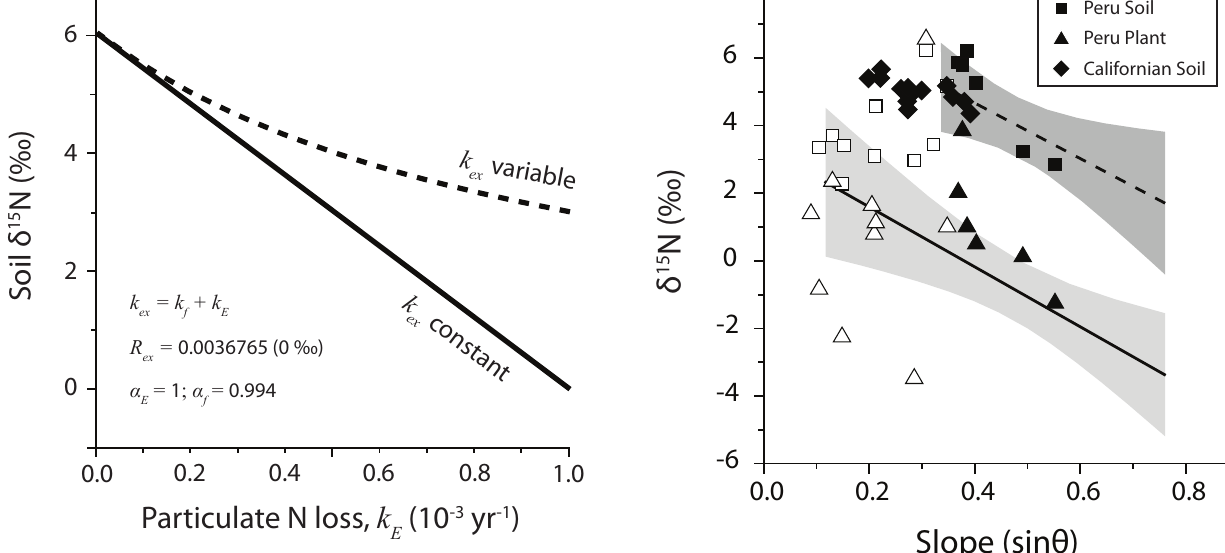
Fig. 6. δ 15 N and slope for soil and plant organic matter from sites in Peru (squares and triangles) and California (diamonds). Lines and shaded regions show linear fits to the soil and plant samples from Taiwan (Fig. 3). Below sin θ = 0.35 ( ∼ 20 ◦ ), erosion rate increases relatively slowly with slope angle. Above this threshold (which re- lates to thresholds in the activity of erosion processes), soil erosion rates increase rapidly, with a much steeper relationship between slope and erosion rate (Roering et al., 1999). For the Peruvian data, filled symbols are those where sin θ > 0.35 (see Sect.